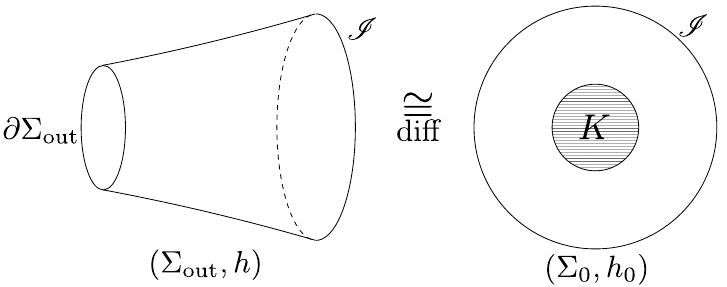
Figure 3 . Example of geometry appearing in Theorem 7. On the left we see an asymptotic “arm” (Σ ) of an asymptotically hyperbolic manifold, where ∂ Σ is outermost minimal. The region out , h out Σ is diffeomorphic to a subset Σ of the hyperbolic plane (Σ ) , and h and h are both out 0 \ K 0 , h 0 0 metrics on Σ (via a judicious choice of out